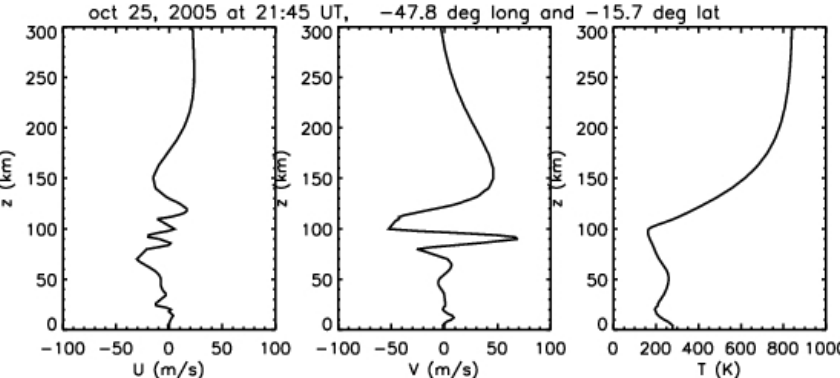
Fig. 4. Zonal (left) and meridional (center) wind and temperature (right) profiles at (45 ◦ W, 10 ◦ S) used for ray tracing the GWs arising from the deep convective plumes observed in Fig. 3. The profiles were defined by balloon soundings below 30km, by meteor radar observations between 80 and 110km, and by a TIME GCM simulation initialized with the NCEP reanalysis data for this same period from 35 to 80km and from 110 to 350km. Note the variable wind structure up to ∼ 110km and the large meridional motions extending to higher altitudes, all of which have significant influences on GW propagation to high